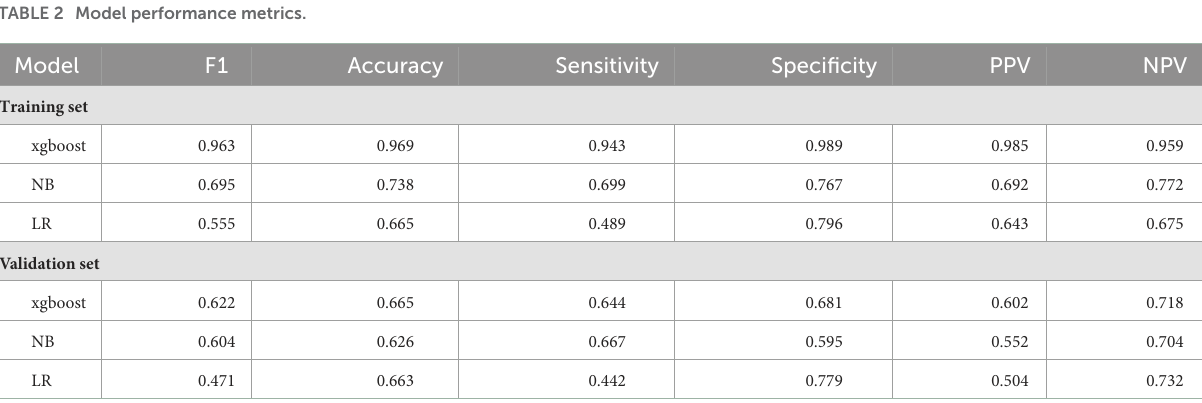
TABLE 2 Model performance